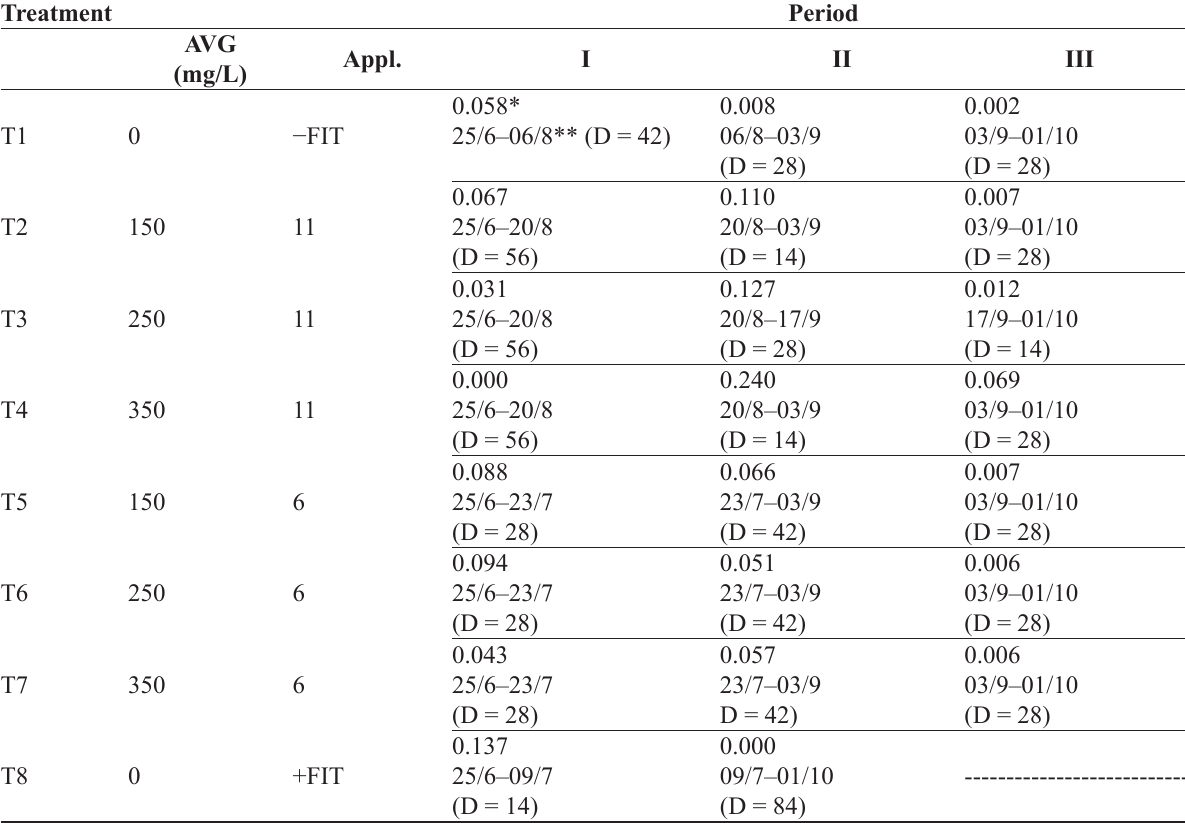
Table 4. Relative rate and periods of inflorescence emergence in the pineapple cv. ‘MD2’ experiment in Satipo in 2018.